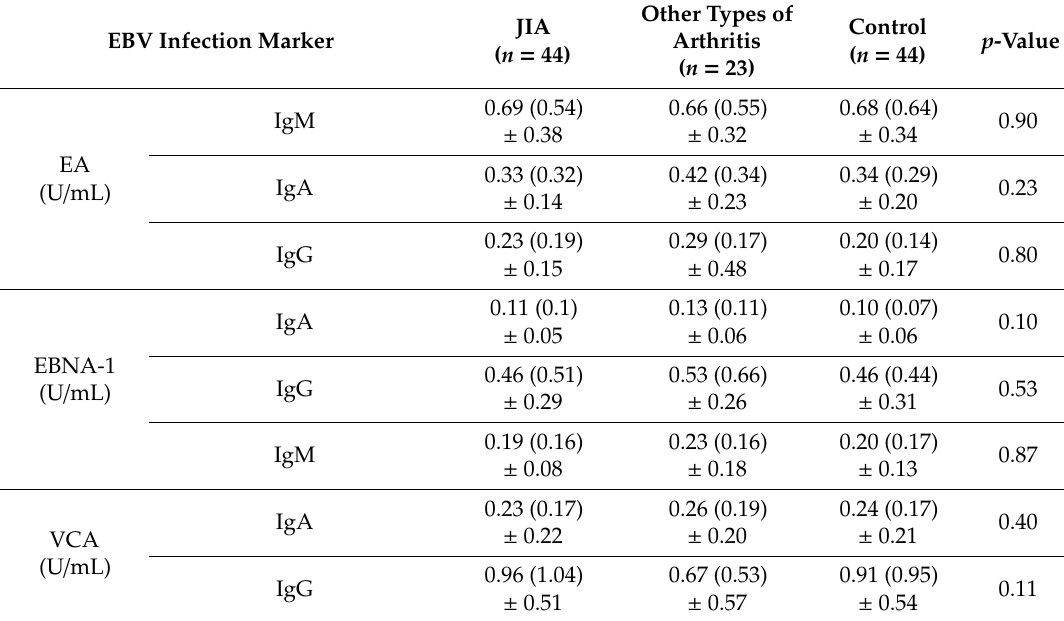
Table 2. Serum concentrations of EBV infection markers in patients with JIA, other types of arthritis, and controls. Results are presented as mean (median) ± standard